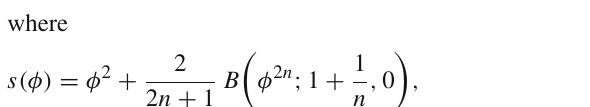
structure.ThiscanbeseenbyexpandingEq.(32),fromwhich